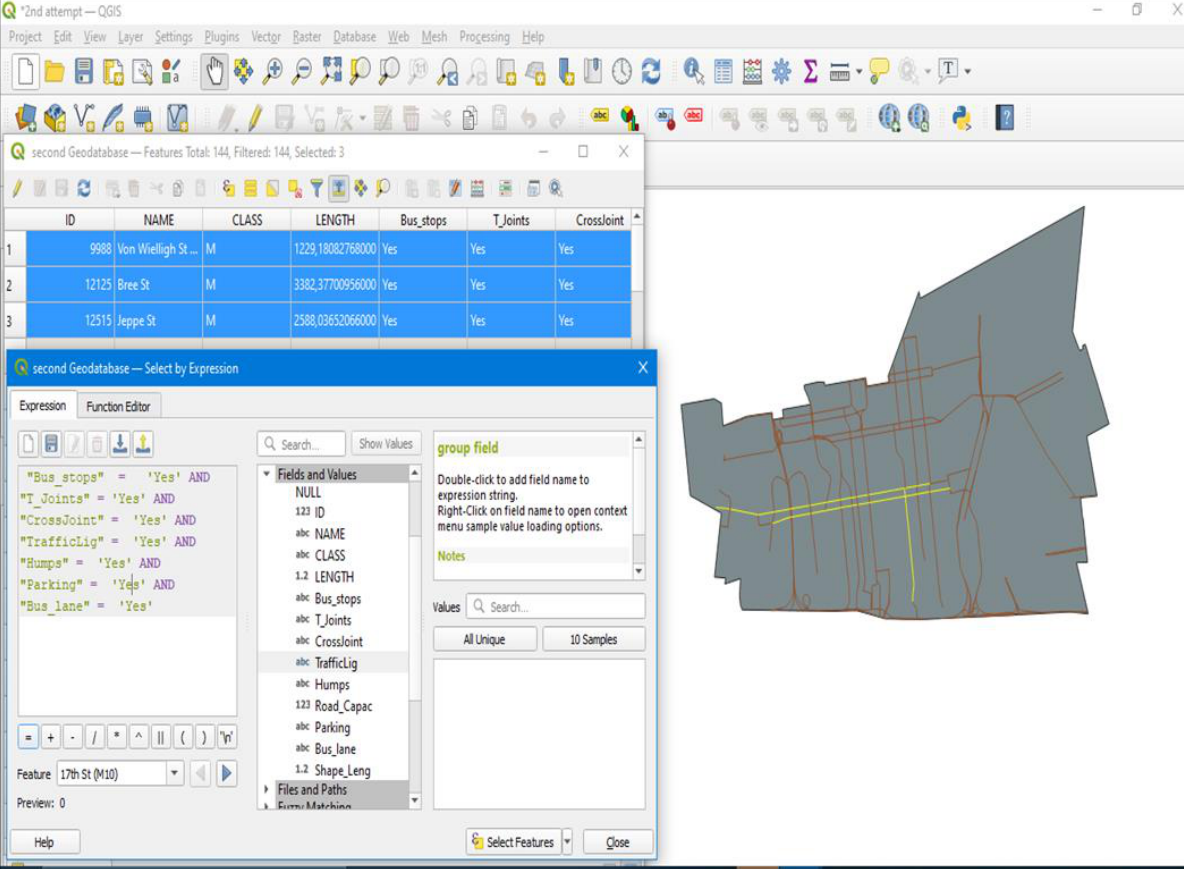
Figure 8 . Road segments with all factors